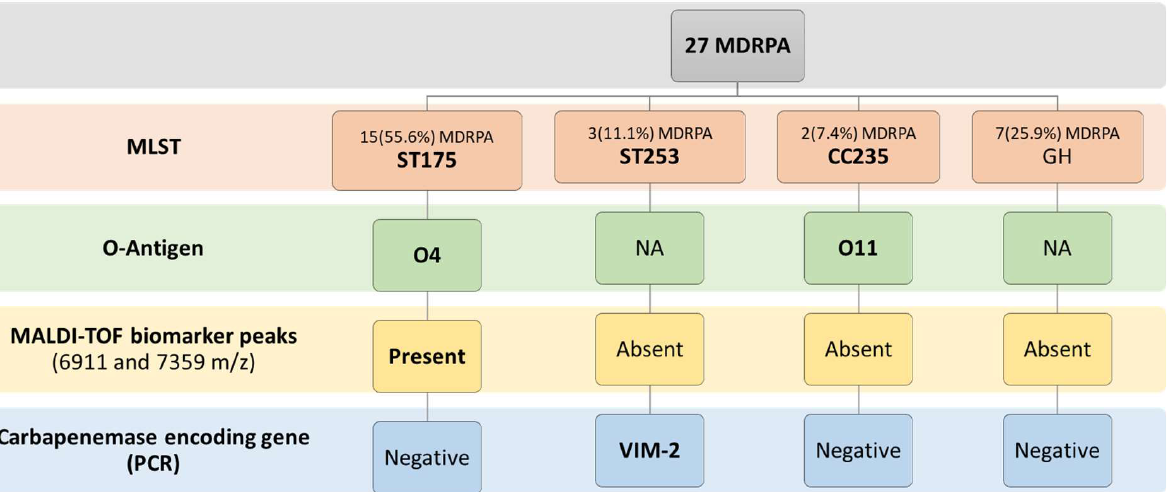
Figure 1. The MLST, O-antigen determination, MALDI-TOF biomarker peaks, and PCR carbapenemase encoding genes results of the MDRPA strains that were isolated from acquisition-positive ICU patients. MDRPA: multidrug-resistant P. aeruginosa ; GE: genetically heterogeneous; NA: no agglutination.